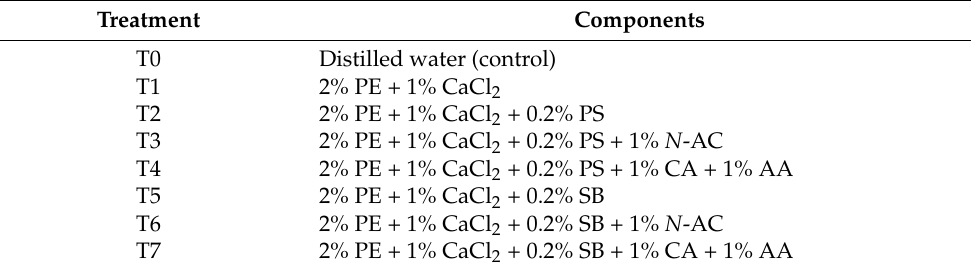
Table 1. Treatment formulations and respective